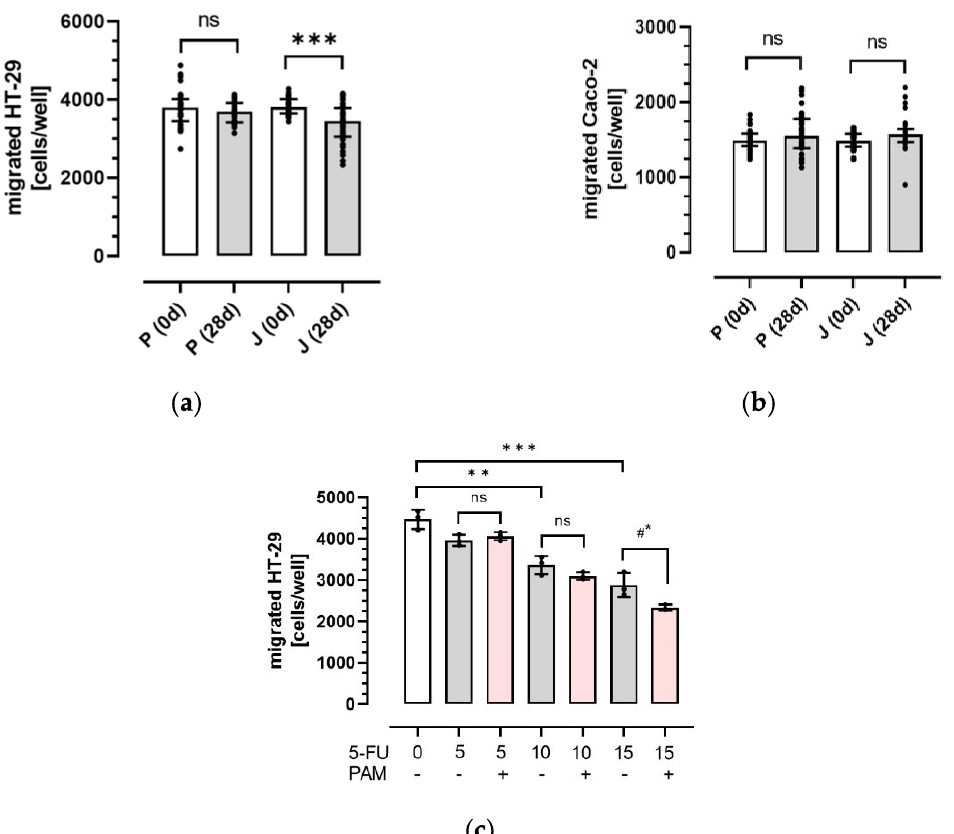
Figure 2. Migration of HT-29 and Caco-2 cells in vitro. HT-29 ( a ) and Caco-2 ( b ) cells were incubated with PAM from the anthocyanin-depleted placebo (P; n = 34) and anthocyanin-rich juice (J; n = 35) that were isolated before (0 d) and after 28-day (28 d) intervention. Migration was studied in a Boyden chamber with collagen-coated transwells. Basal cells in the lower chamber were measured after 36 h and migrated cell counts were detected fluorometrically as described in the Methods section. HT-29 cells ( c ) were exposed to indicated concentrations of 5-FU alone (5, 10, and 15 µ M) and with pooled PAM ( n = 10; most effective from ( a )). Values are presented as aligned dot plots with median and interquartile range (25th–75th) ( a , b ) or means with standard deviation ( c ). Significant differences were calculated with a mixed model with multiple comparison test (Š í d á k’s) or ANOVA with multiple comparison test (Š í d á k’s). Values were different with ** p < 0.01 and *** p < 0.001 compared with